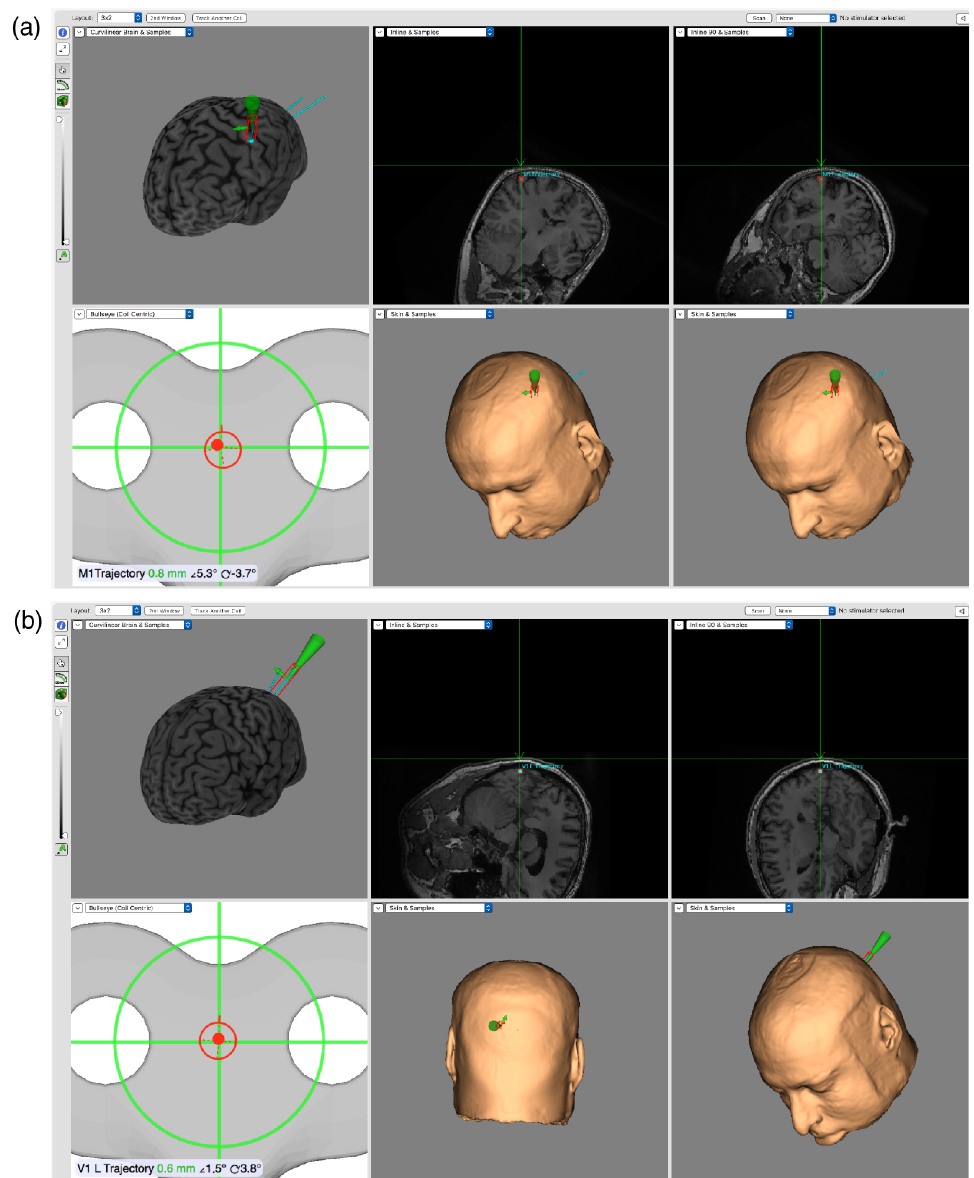
Figure 3. Localization of the hotspot for the motor threshold ( a ) and for the V1 cortex ( b ) with